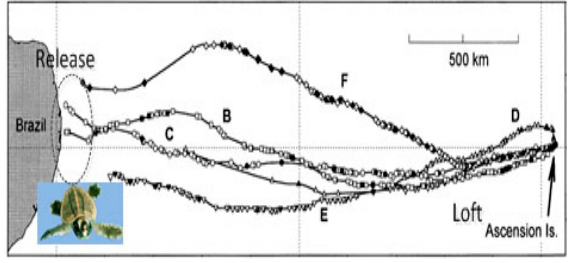
Figure 2. Trajectories of migrating sea turtles.